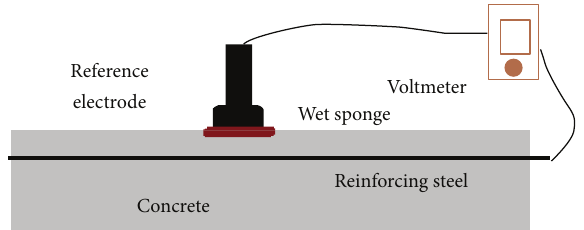
Figure 3: Setup of half-cell potential measurement.